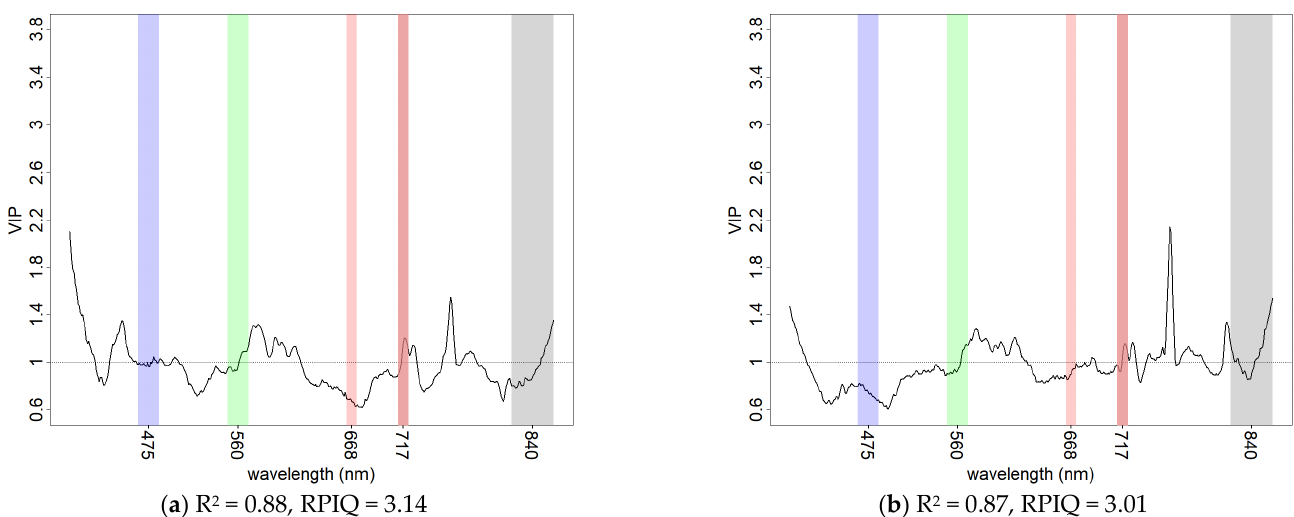
Figure 12. VIP scores of KE PLSR models from hyperspectral data using: ( a ) reflectance vis-NIR range; ( b ) SNV vis-NIR range. Goodness of fit is reported with R 2 and RPIQ. The multispectral broad-bands of the Rededge-M camera model are shown for comparison.